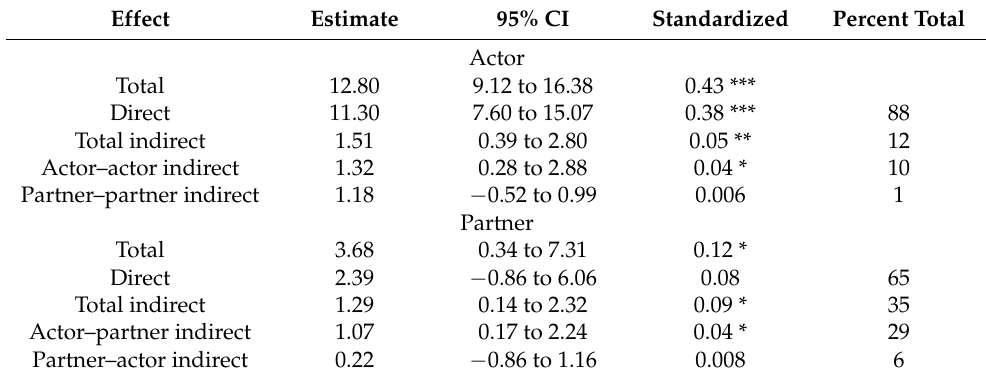
Table 7. Effects of other-perceived delegated DC